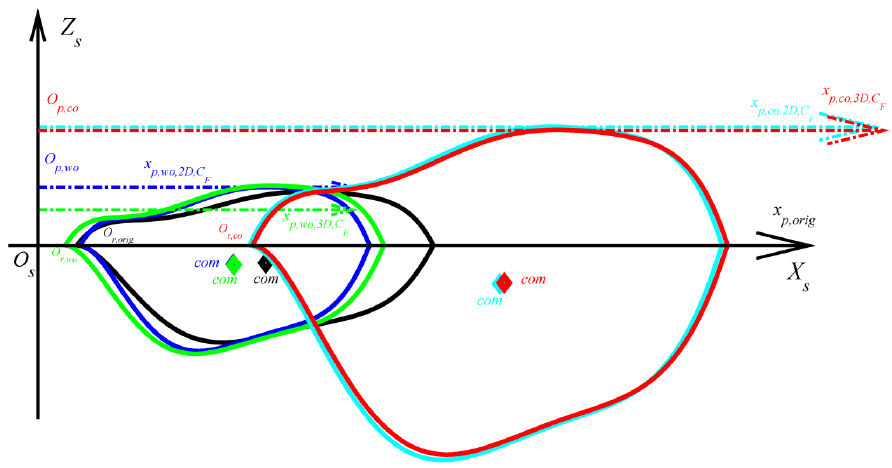
Figure 13. The original and dynamically scaled wing planform of fruit fly .